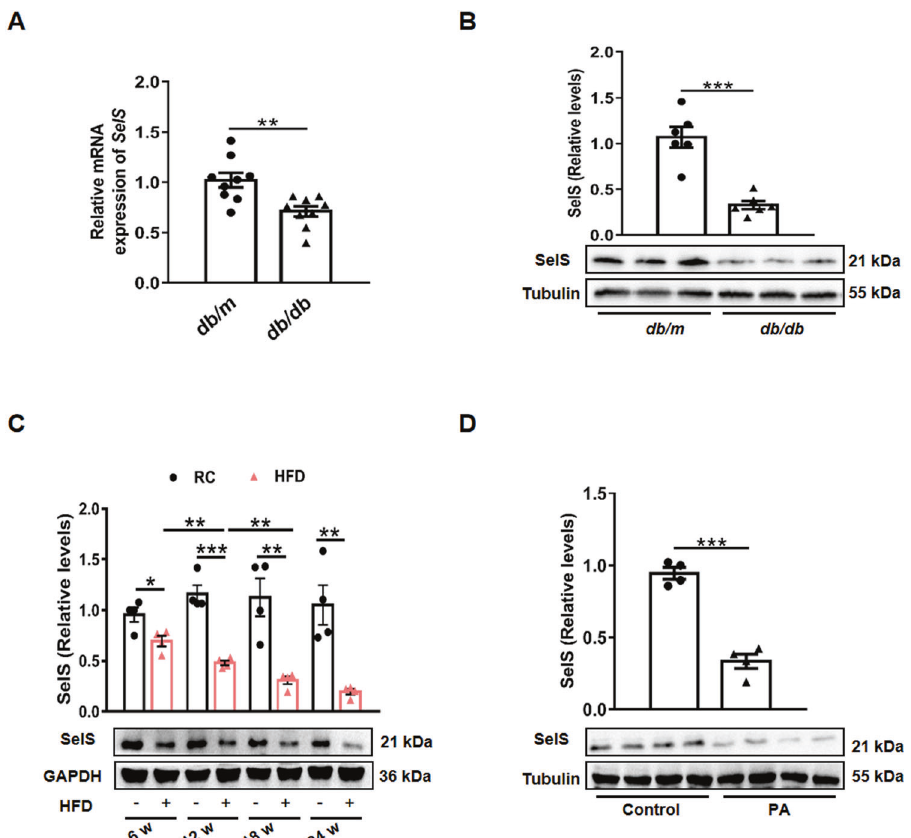
Fig. 1 Regulation of SelS expression in the mouse liver and primary hepatocytes. A SelS mRNA expression in the liver of db/m and db/db mice ( n = 9 per group). B Representative Western blotting images from 3 mice out of 6 for each group and quanti fi ed protein levels of SelS in the liver of db/m and db/db mice ( n = 6 per group). C Representative Western blotting images from one mouse out of 4 for each group and quanti fi ed protein levels of SelS in the liver of wild-type mice fed with RC or HFD for 6 w, 12 w, 18 w, or 24 w ( n = 4 per group). D Western blotting and quanti fi ed protein levels of SelS in the primary hepatocytes isolated from wild-type mice treated with 0.5 mM PA for 24 h ( n = 4 per group). All data are presented as the mean ± SEM. * P < 0.05, ** P < 0.01, *** P < 0.001. SelS, selenoprotein S; RC, regular chow; HFD, high-fat diet; PA, palmitic